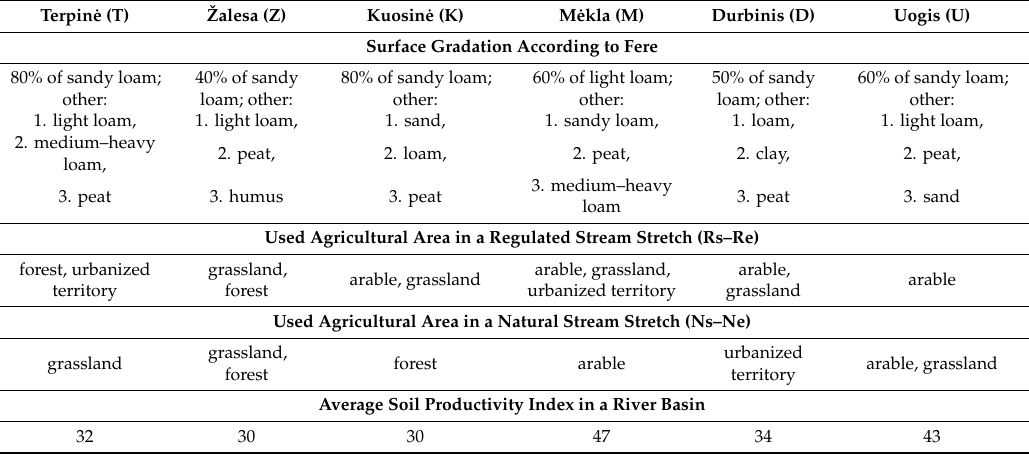
Table 3. Soil gradation, used agricultural areas and soil productivity index of the river basins. Terpin˙e (T) Žalesa (Z) Kuosin˙e (K) M˙ekla (M) Durbinis (D) Uogis (U) Surface Gradation According to